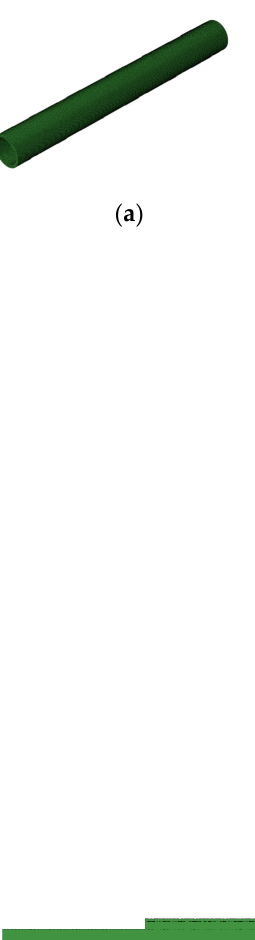
Figure 6. Diagrams of model meshes. ( a ) Sleeve. ( b ) Reinforcement. ( c ) Grouting material. ( d )